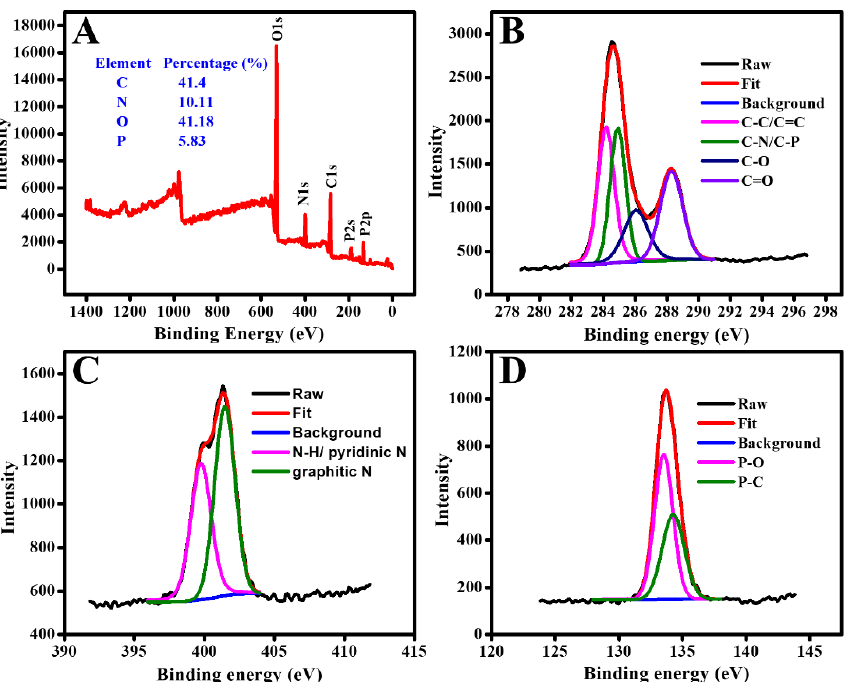
Figure 3. ( A ) XPS survey spectra of NPCDs. High-resolution XPS spectra of ( B ) C1s, ( C ) N1s, and ( D ) P2p, respectively.